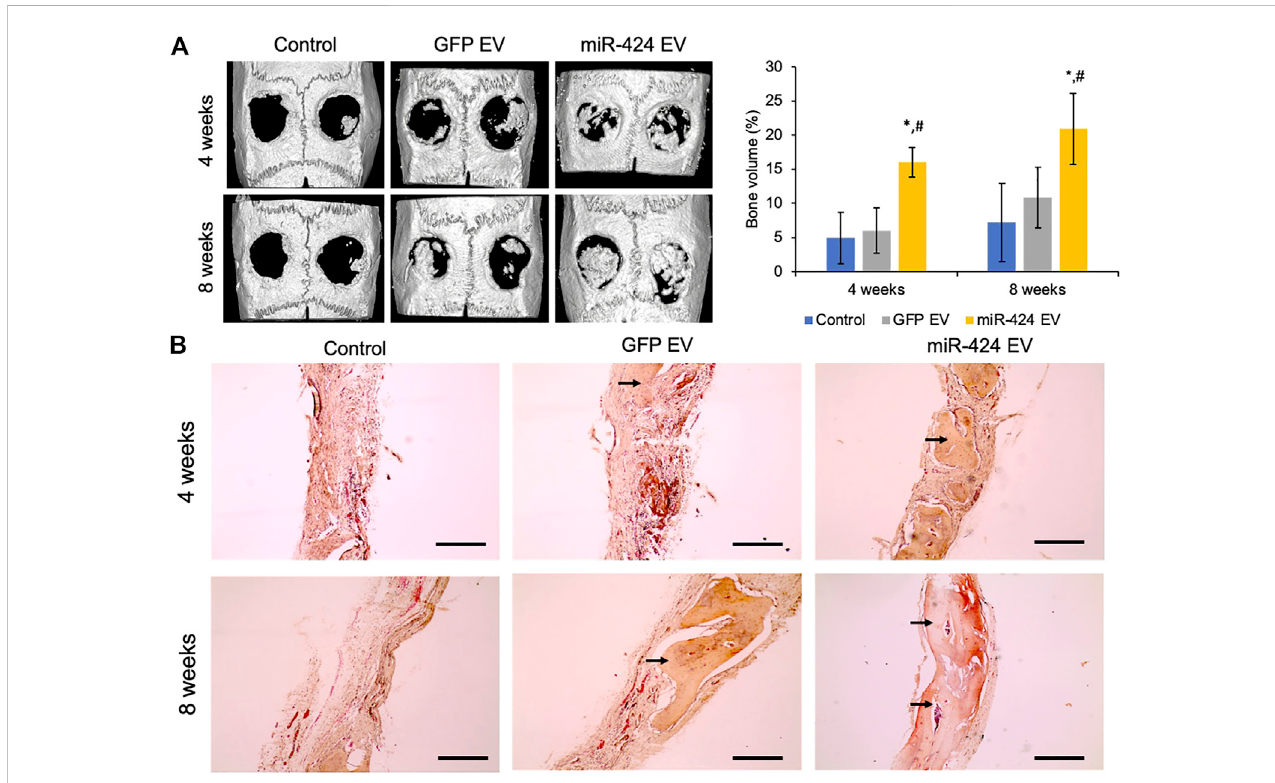
FIGURE 7 In vivo osteoinductive properties of the engineered EVs. (A) Representative μ CT images of calvaria from control and EV treated groups after 4 and 8 weeks post wounding followed (right) by volumetric quantitation of bone formation in the defects. Note the signi fi cant increase in bone volume in the 424 EV treated groups compared to both controls. *represents signi fi cance with respect to control and # represents signi fi cance with respect to control EV group measured by Tukey ’ s test post ANOVA. (B) Representative micrographs (10x) of sections of decalci fi ed calvaria stained with H&E stain. The arrows point to the presence of bone in the defects. Note the increased levels of bone in the 424 EV treated calvarial sections. Scale bar represents 100 μ m in the micrographs.